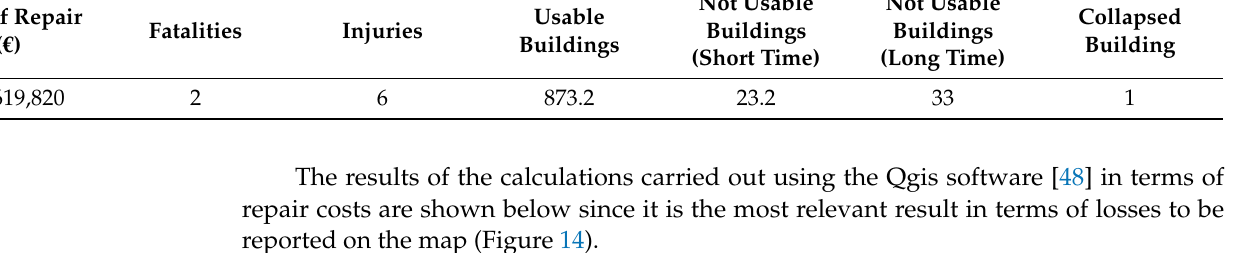
Figure 15. Map outlining the priorities for intervention in the historic center of Lisbon.